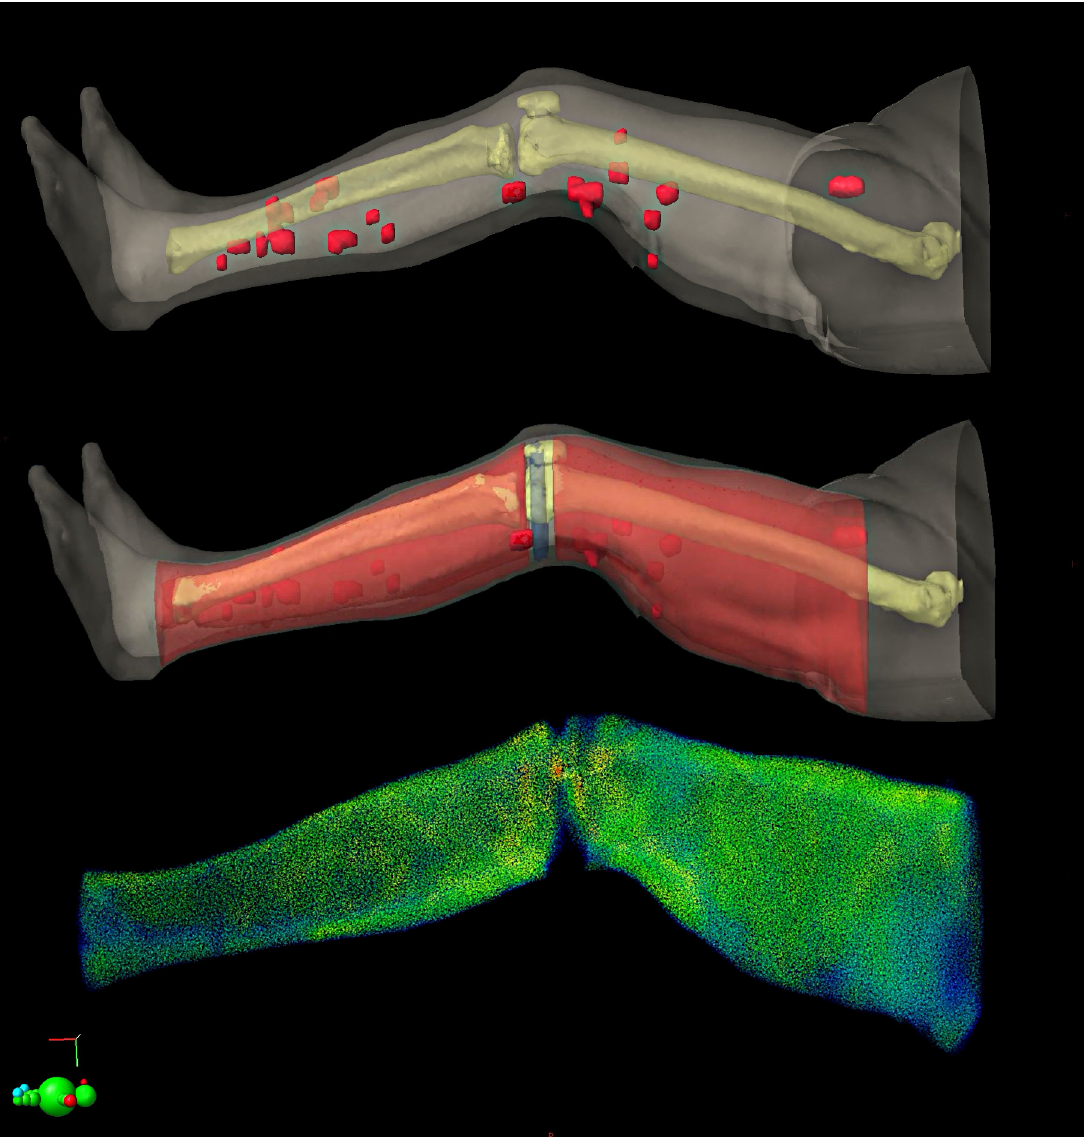
Figure 2. Three-dimensional reconstruction of macroscopic nodules ( top ), treatment volumes of the thigh and leg (red) ( middle ) and dose distribution ( bottom ).